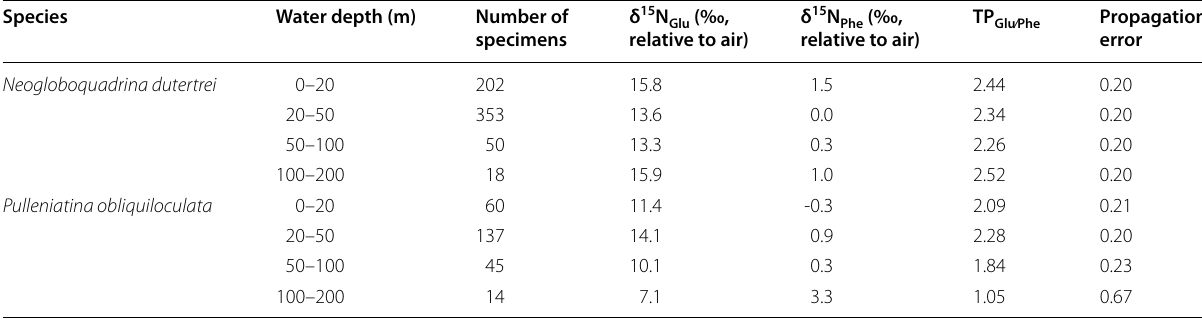
Propagation error in TP Glu/Phe was calculated in Eq. (5)